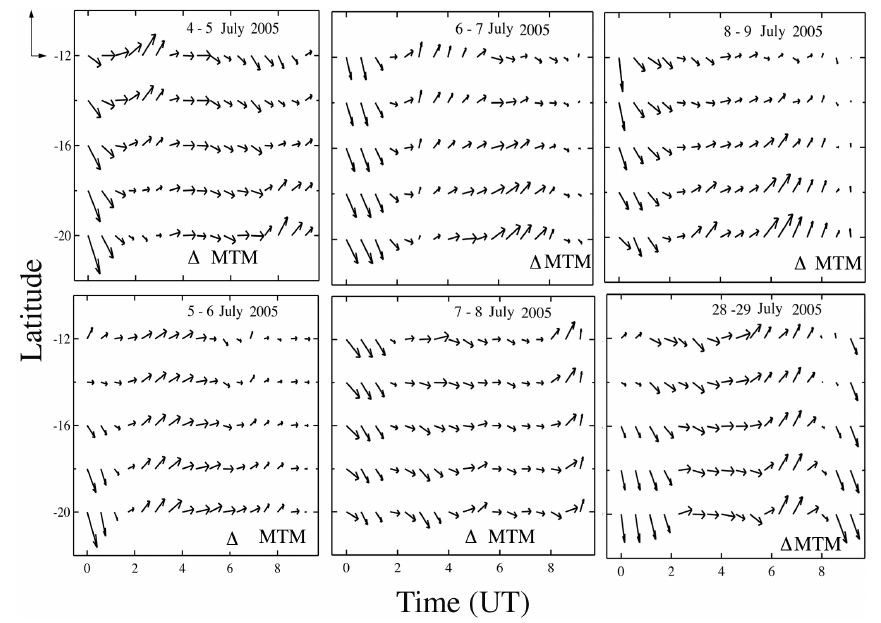
Fig. 11. Horizontal wind maps for six nights of observations in July 2005. Neutral wind vectors are computed for 2 ◦ intervals of latitude between − 12 ◦ and − 20 ◦ and every 30min in UT. Local midnight occurs at 05:00UT. The horizonal meridional or zonal wind speed of 100ms − 1 is represented by the distance of 2 ◦ latitude or 30min, respectively; a scale insert is shown in the upper left corner. The UT position of the maximum of the MTM event is indicated by the triangle next to the MTM label; the amplitudes are 75K, 90K, 75K, 0K, 100K, and 100K, respectively, for these six